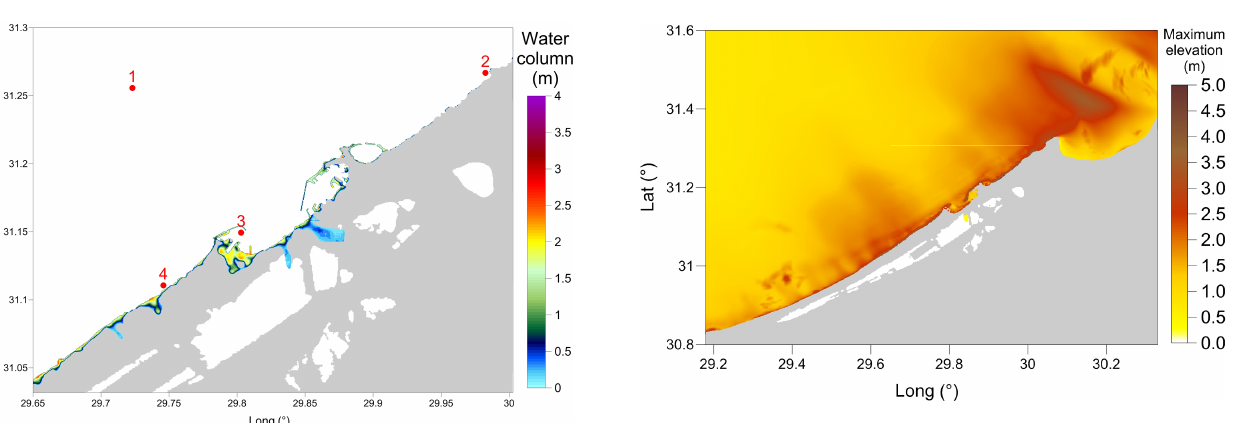
Figure 6. Water depth maxima on land for the WHA case plotted in grid 4 (40m resolution) in mean-sea-level conditions. Red cir- cles show the position of four virtual tide gauges: gauge 1, quite far offshore, and the other three, very close to the coast.